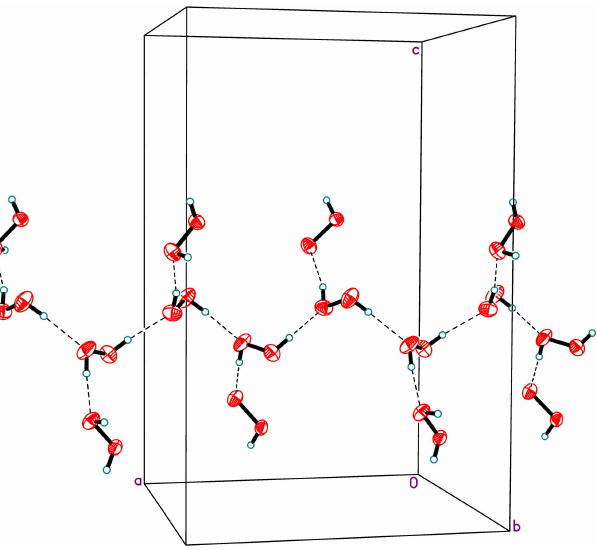
Figure 7. Hydrogen bonded chains along a -axis in III . Hydrogen bonds are shown by dashed